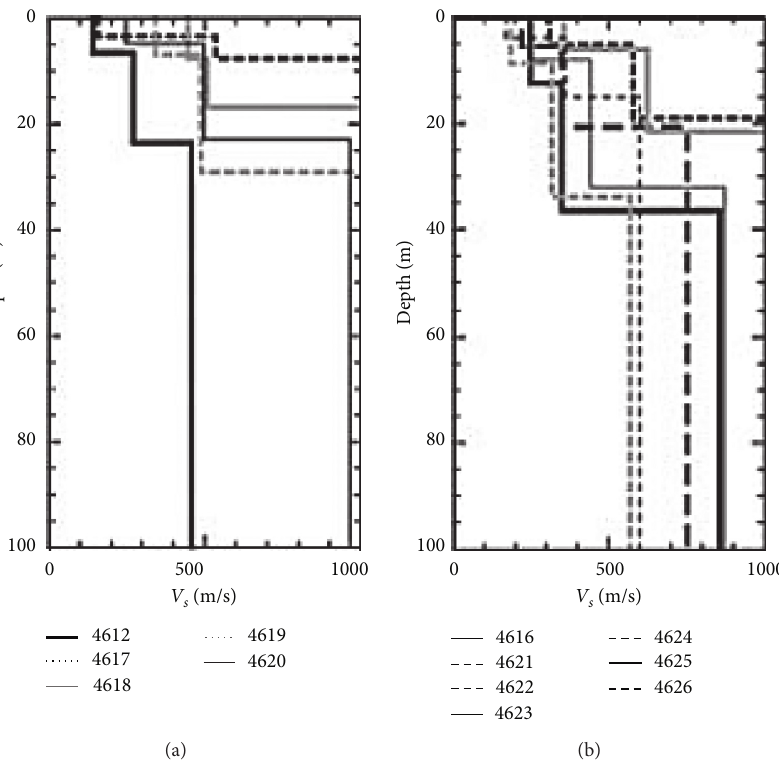
Figure 4: The V S profiles implemented by MAM test in the study area [8].